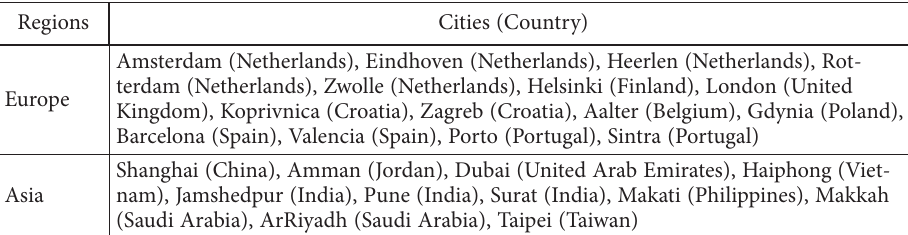
Table 2. List of Smart Cities Regions Cities